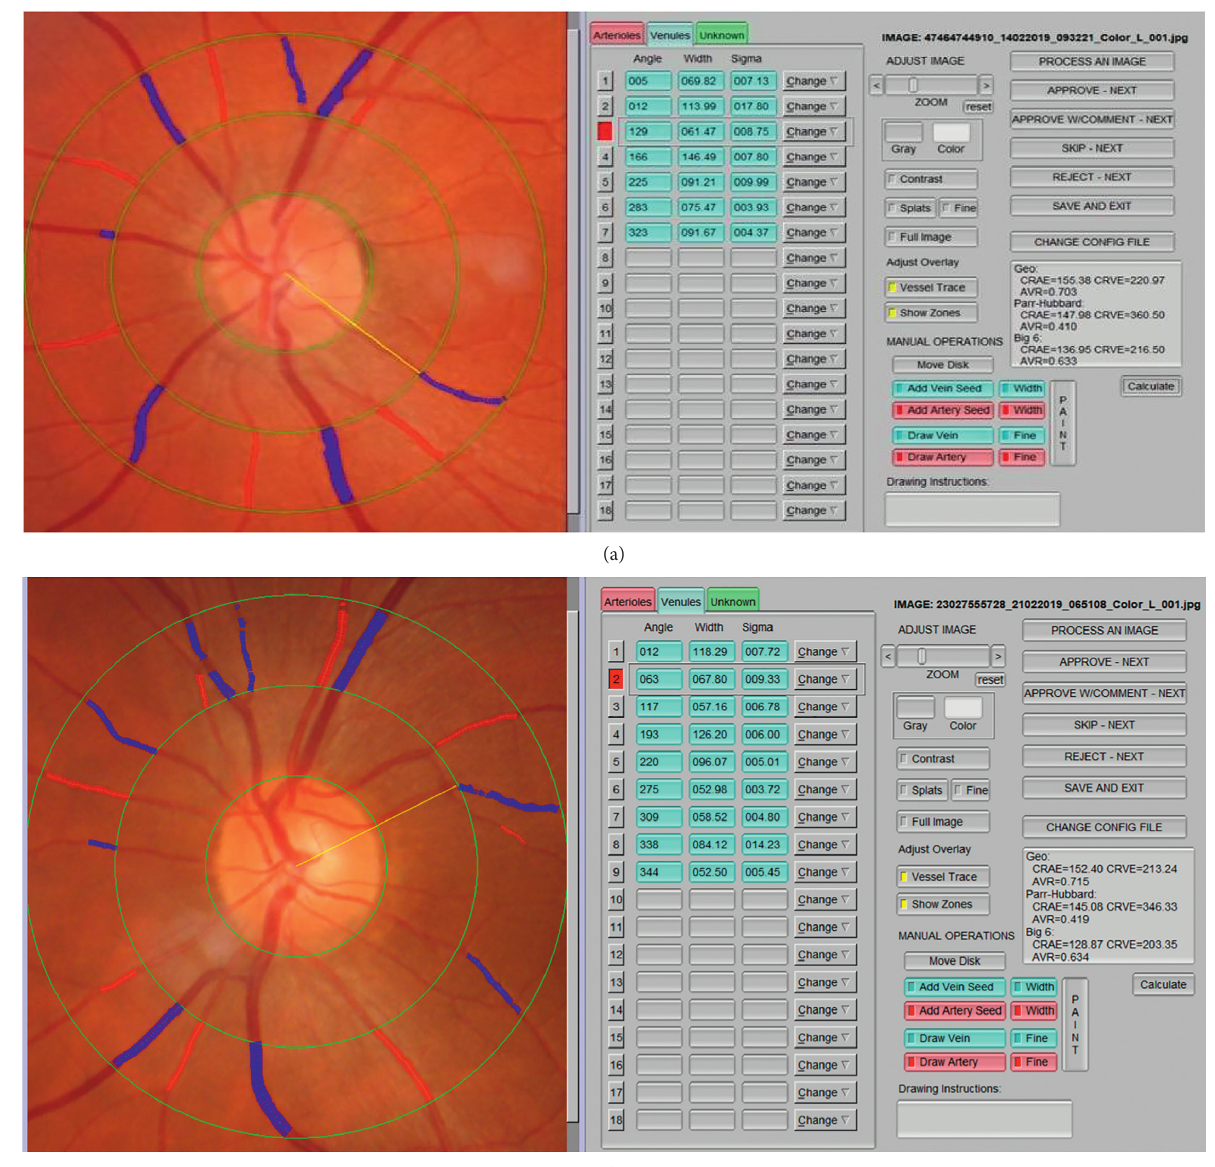
Figure 2: The measurements of CRAE and CRVE parameters in a (a) patient with inactive GO and (b) control